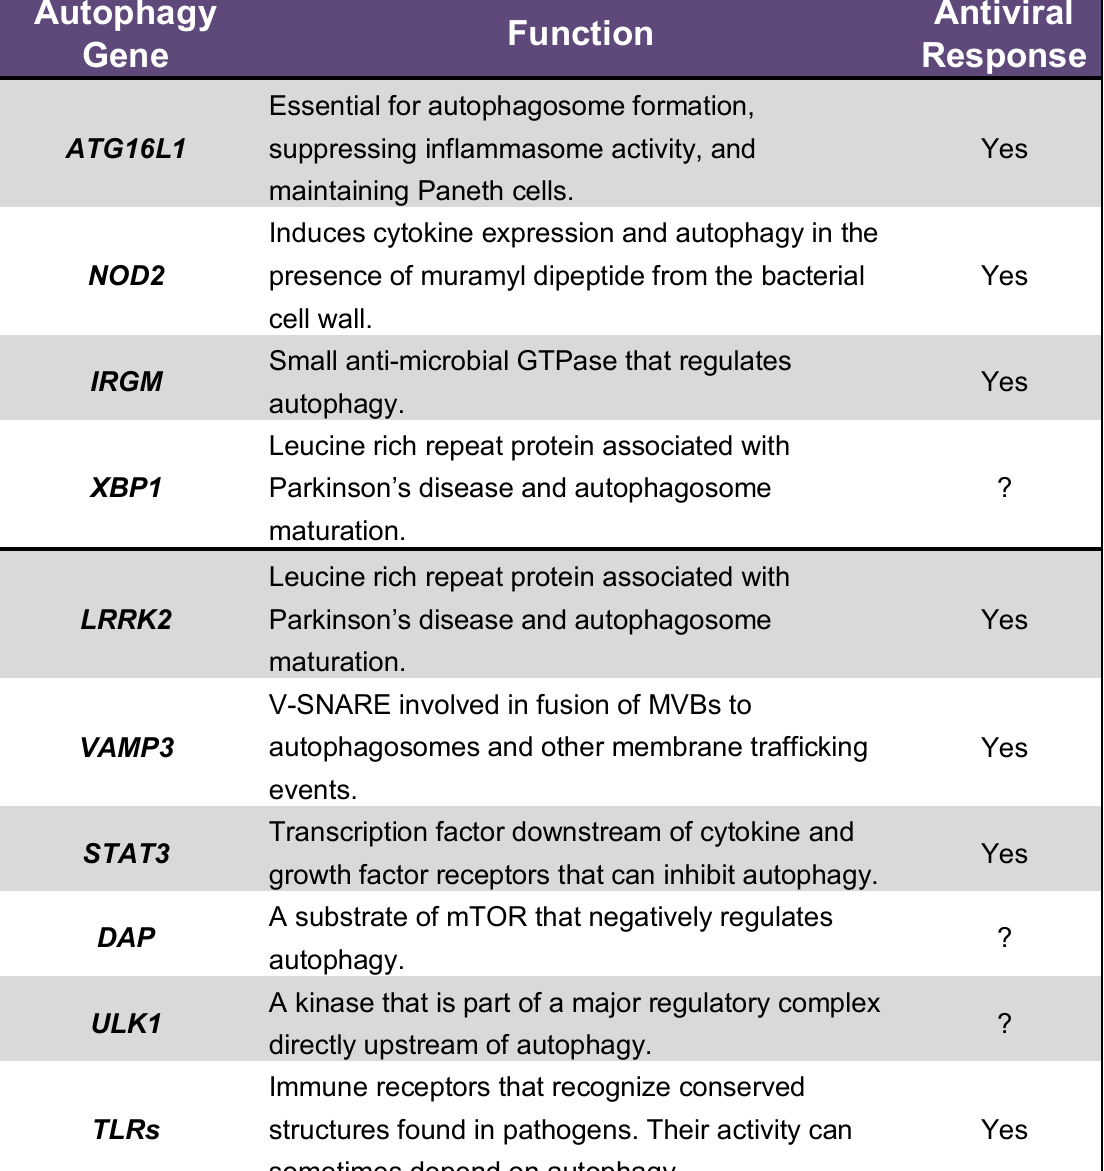
Table 1. Genes related to the autophagy pathway associated with inflammatory bowel disease. The association between inflammatory bowel disease and the genes below the divider requires further validation. The right column indicates if a gene has been demonstrated to function in an antiviral